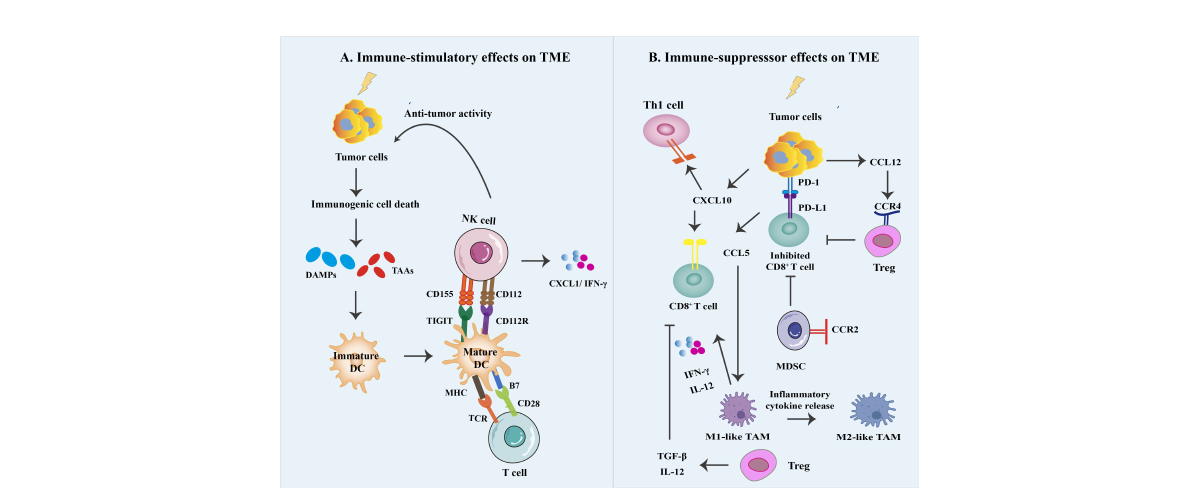
FIGURE 3 Different immune effects on the irradiated tumor microenvironment. (A) The generated cellular stress and death mediate immunogenic cell death (ICD) by the generation of damage-associated molecular patterns (DAMPs) and their corresponding pattern recognition receptors (PRRs). ICD can trigger a series of antitumor immune responses. This process requires DAMPs signaling through various PRR types, activating DC, NK cells, and CD8 + T cells and increased production of associated in fl ammatory cytokines. Eventually, in fl ammatory signaling is increased, starting DCs and maturing them into potent antigen-presenting cells APC. (B) RT can produce a variety of chemokines that promote and antagonize anti-tumor responses, e.g., T cells and M1 macrophages can be recruited via CXL10 and CCL5, respectively, to eliminate tumors. In contrast, myeloid-derived suppressor cells (MDSC) can have immunosuppressive effects through radiation-induced recruitment of CCL12 expression. In addition, small doses of radiation delivered during conventional fractionated radiation therapy are thought to contribute to the accumulation and immunosuppressive effects of immunosuppressive cell types in the TME, such as myeloid-derived suppressor cells (MDSCs) and M2 macrophages to suppress antitumor immunity and PD-1/PD-L1 suppressor signaling to suppress antitumor